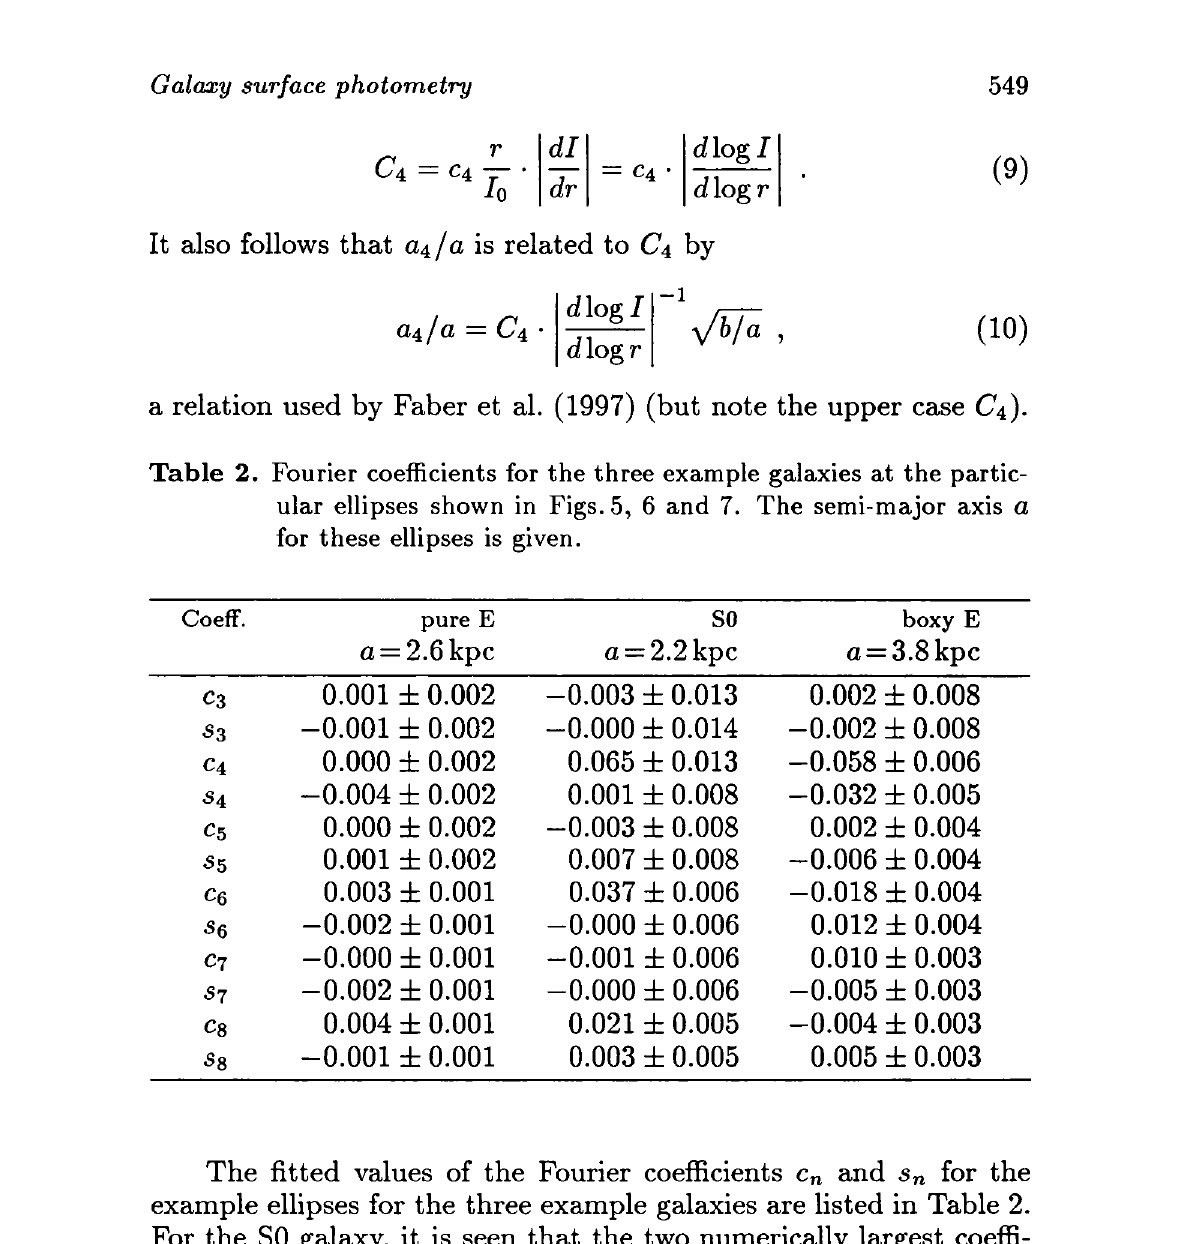
Table 2. Fourier coefficients for the three example galaxies at the partic- ular ellipses shown in Figs. 5, 6 and 7. The semi-major axis a for these ellipses is